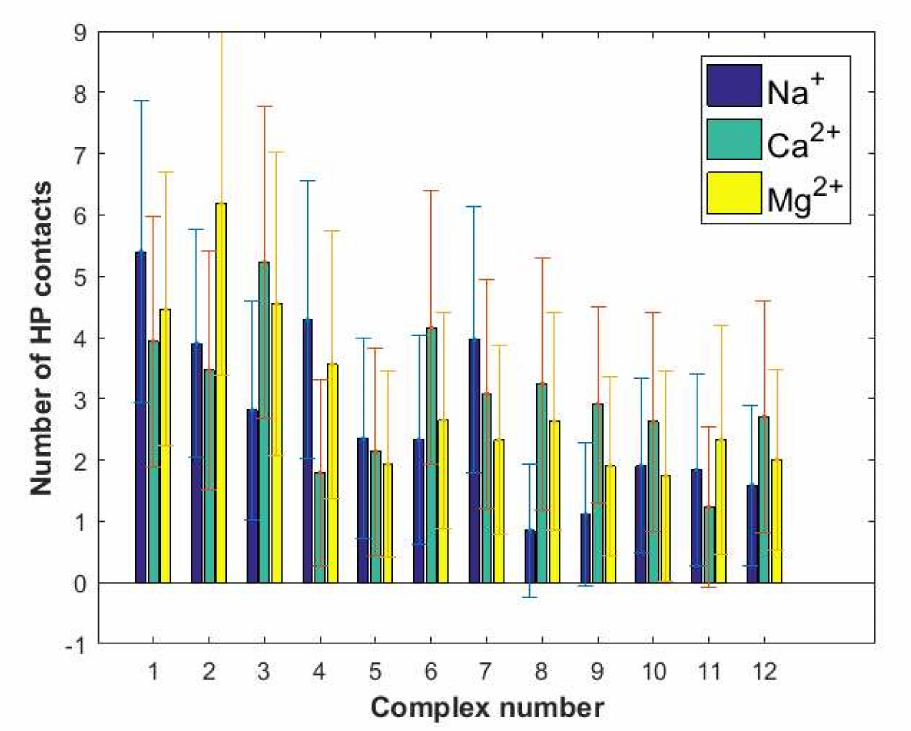
Figure 9. Number of hydrophobic interactions between HSA and